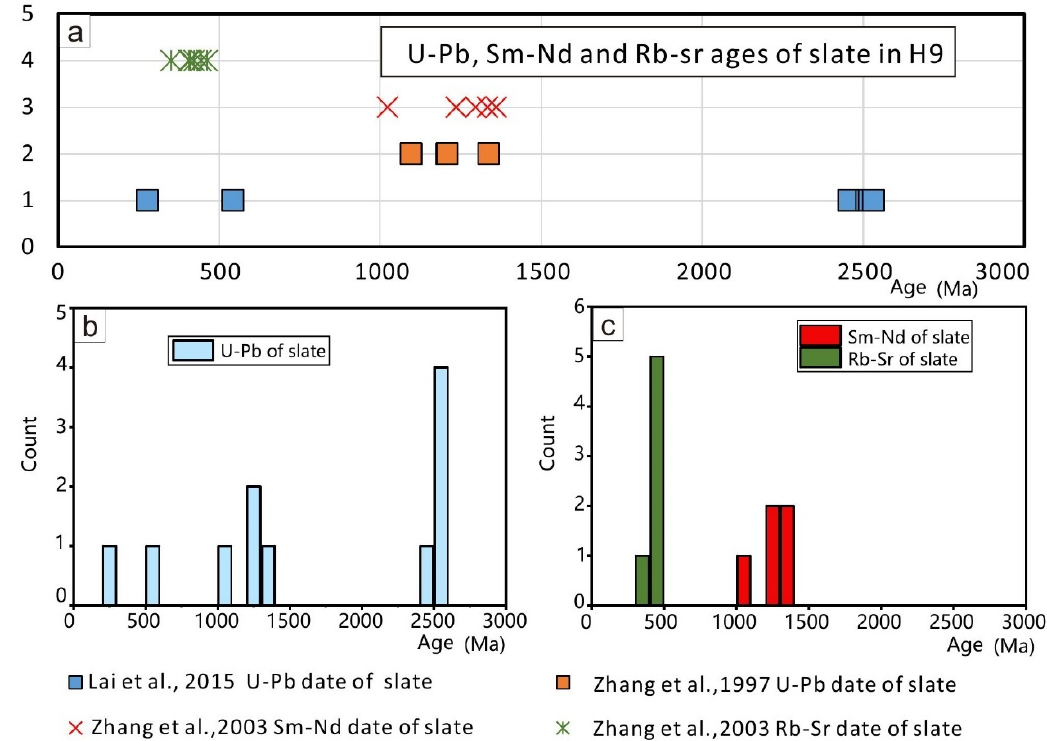
Figure 15. Age distribution characteristics of U–Pb and Th–Pb of slate from H9. ( a ) Single age distribution characteristics corresponding to different studies. ( b , c ) Stack histograms of all ages [9,21,34,48].